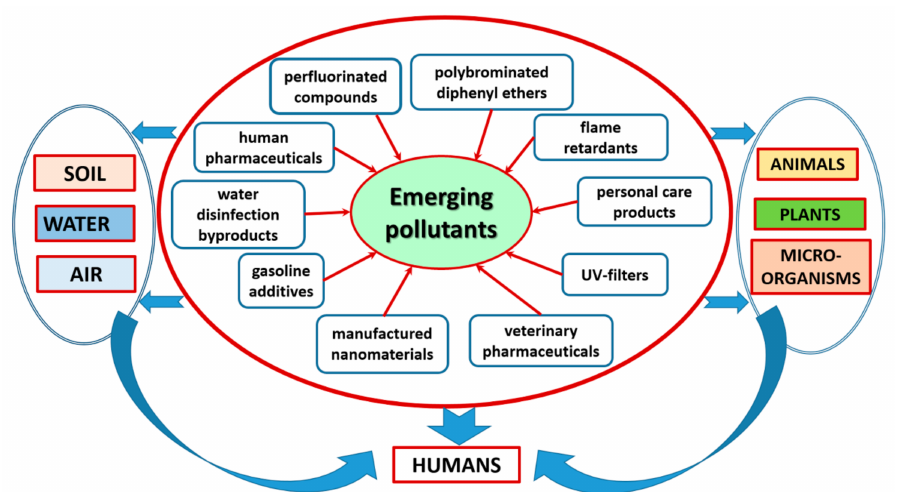
Figure 1. Categories of emerging pollutants that impact on soil, air, water, animals, plants, microor- ganisms and humans (adapted upon